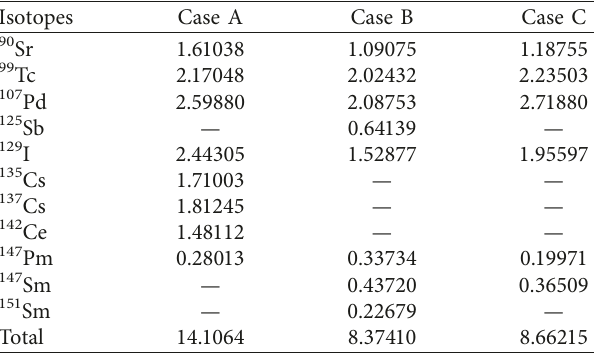
Table 5: Production of FPs in the subcritical fuel zone at the end of operation times